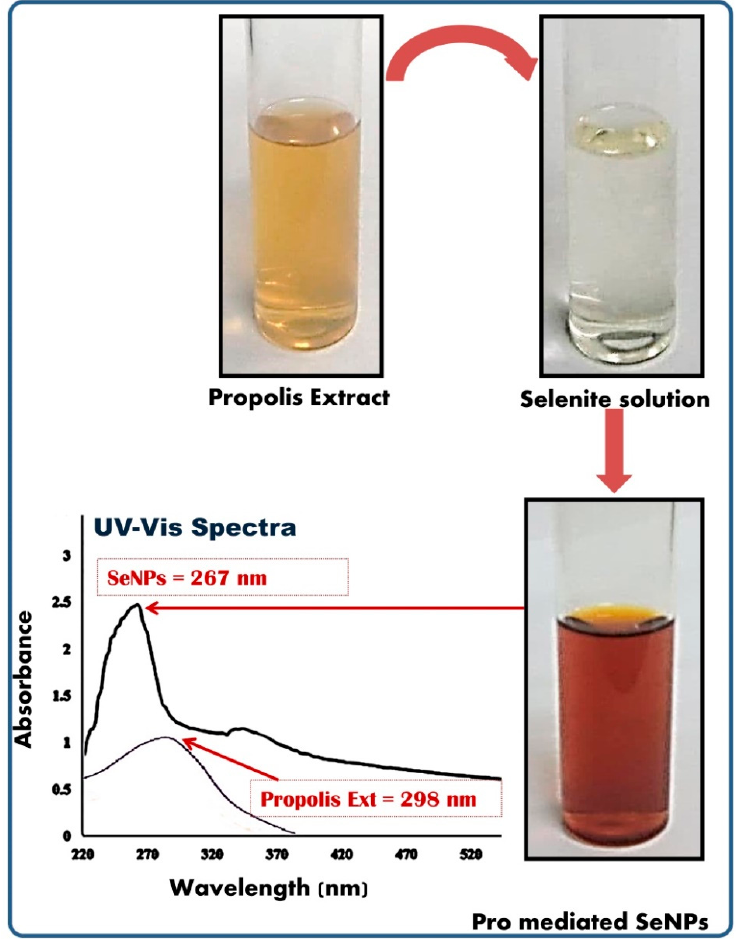
Figure 2. Visual appearance and UV-Vis spectrum of biosynthesized SeNPs using propolis extract.